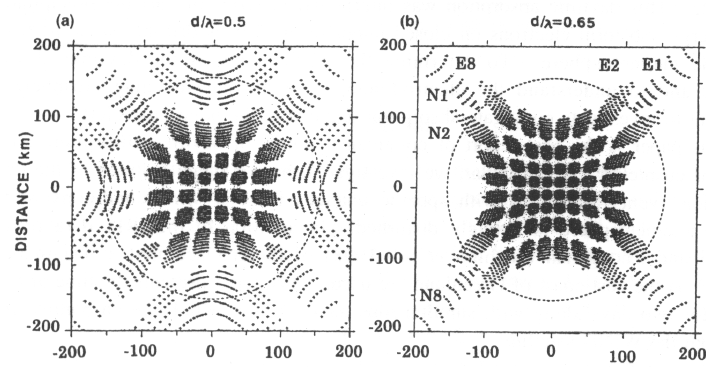
Fig. 6. The projection of a half-power width of the 64 antenna beams onto an ionospheric absorption altitude of 90 km. The patterns are shown for (a) 0.5 wavelength spacing at Zhongshan station and (b) 0.65 wavelength spacing at Ny-Ålesund station.